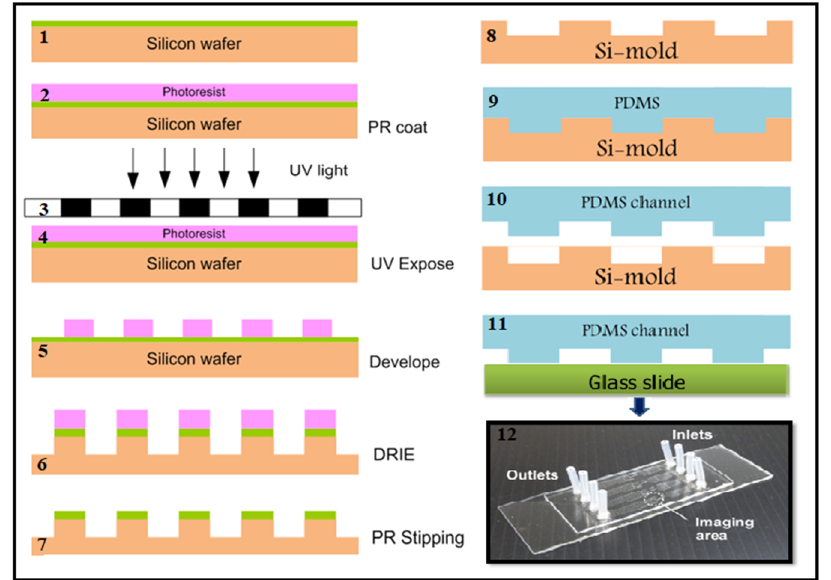
Figure 1. Diagram of the silicon-mold creating ( 1 – 7 ); polydimethylsiloxane (PDMS) casting ( 8 – 10 ); PDMS channel and glass slide bonding ( 11 ) and the fabricated microfluidic chip ( 12 ).